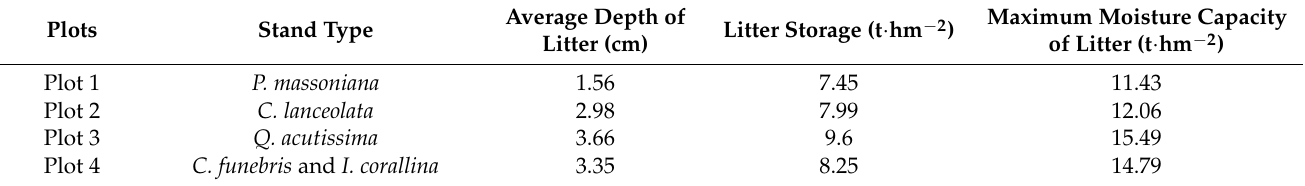
Comparison of litter depth, storage and water holding capacity among different experimental